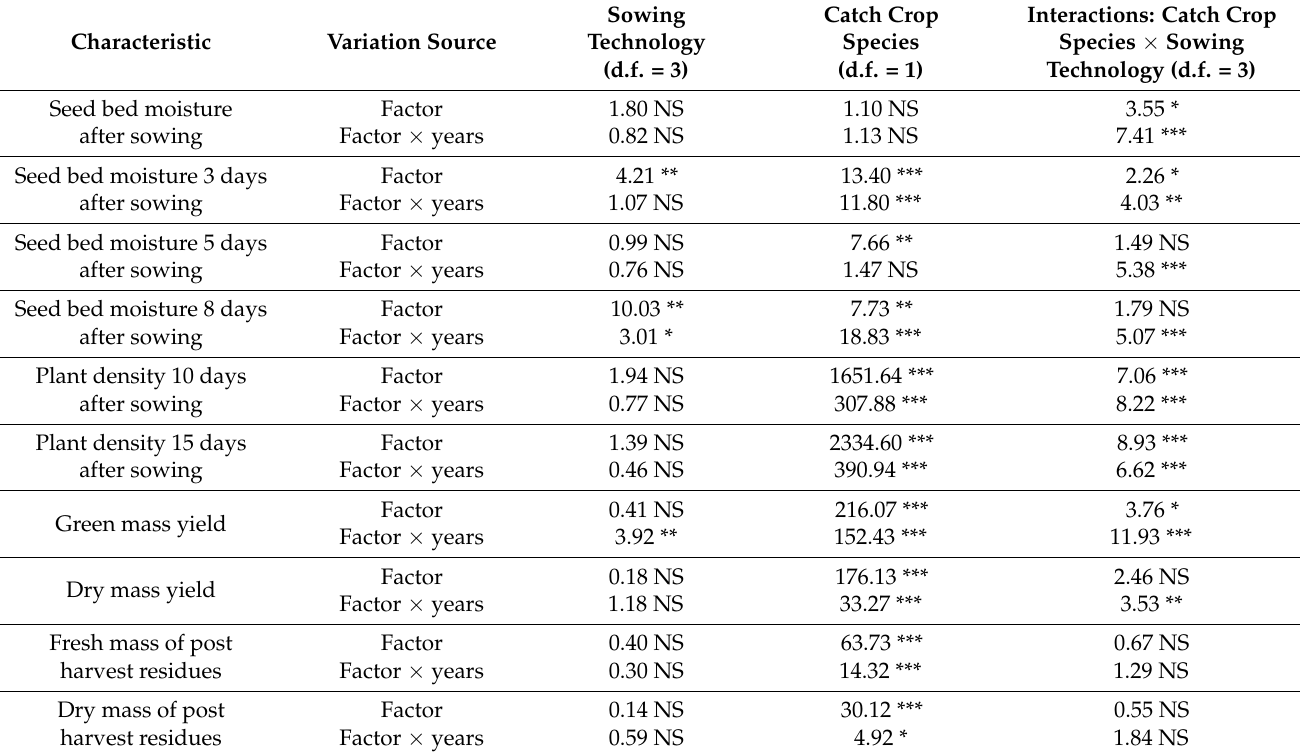
Table 2. Statistical differences ( F -values and significance level) between means of variables by two-way ANOVA with factors of catch crop species and sowing